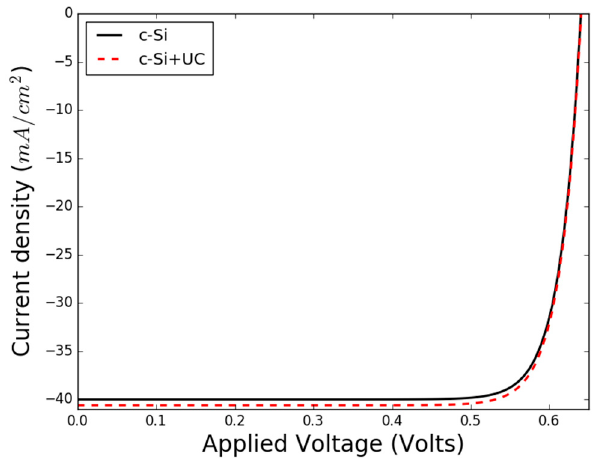
Figure 3. Simulated J–V curve for an ideal c-Si solar cell with and without up-conversion (UC). Without the frequency conversion layer, the efficiency of the model c-Si solar cell is 21.4%, with a short circuit current of J sc = 400 A and an open circuit voltage of V oc = 0.56 V. Using Equation m 2